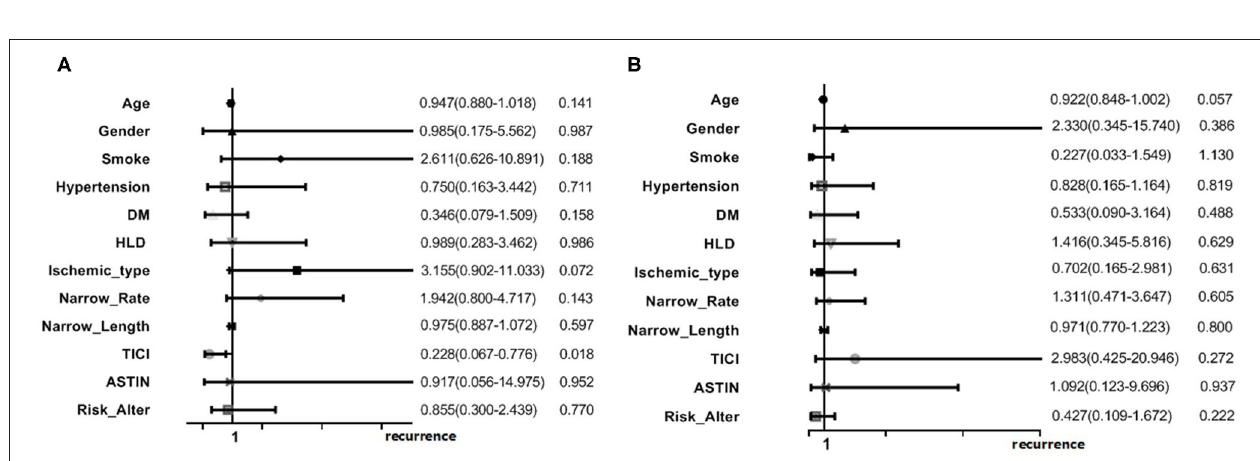
FIGURE 3 | The 1-year recurrent rate compared between two groups using the Kaplan-Meier method.